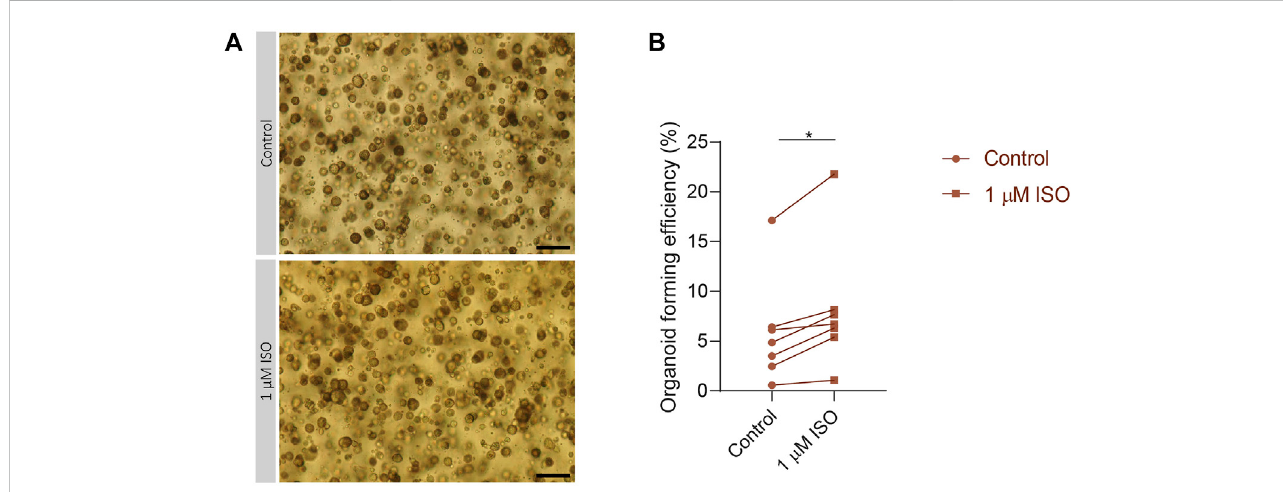
FIGURE 4 Isoproterenol increases OFE in PIC-cultured SGOs (A) Representative images of PIC-cultured organoids in culture treated with or without 1 µM isoproterenol. Scale bar = 200 µM (B) Organoid forming ef fi ciency after treatment with 1 µM isoproterenol. Each dot represents a different patient ( n = 7). Statisticalsigni fi cance ( p =0.0156) between thecontrol and isoproterenol treated group wasdetermined usingWilcoxonmatched-pairs test. * p < 0.05, ** p < 0.01, *** p <